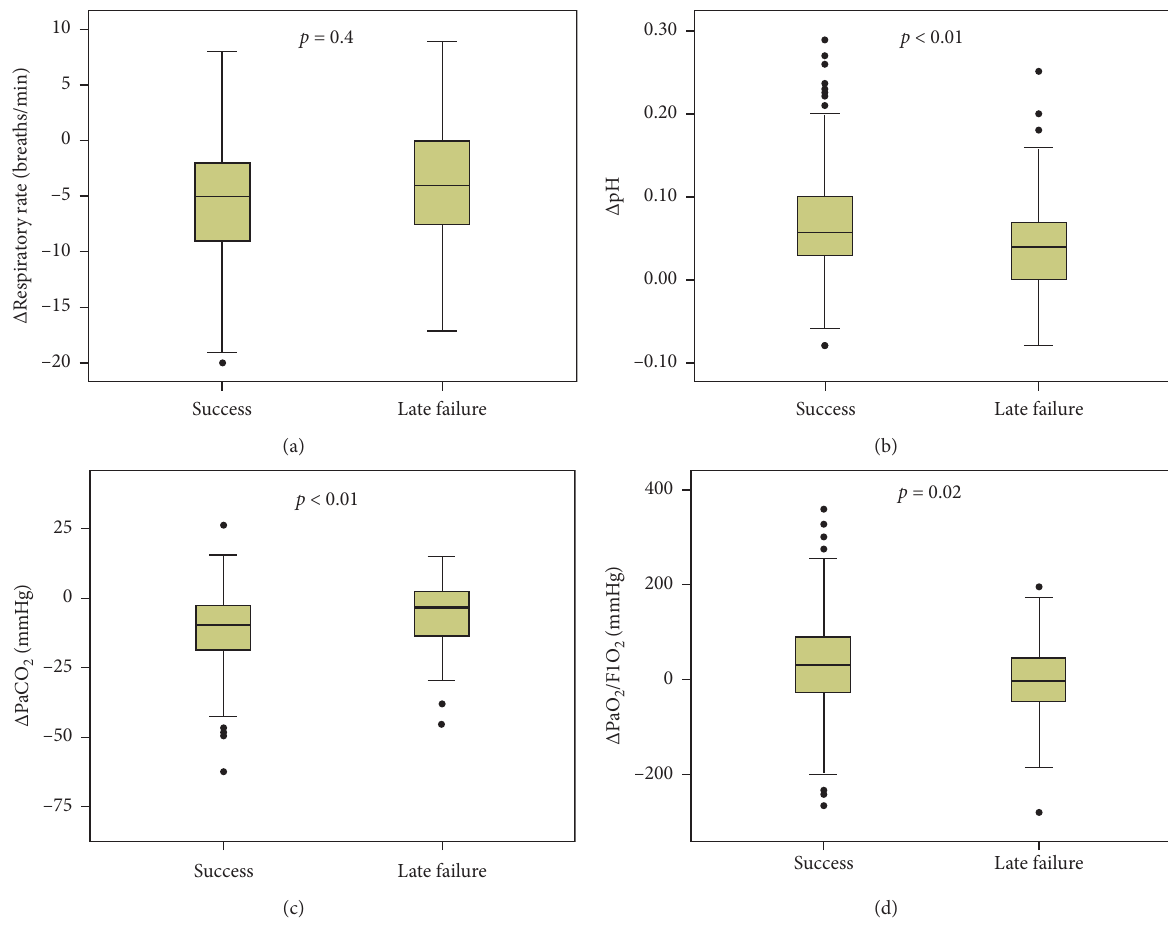
Figure 3: Changes of vital signs from initiation to 1–2h of NIV.